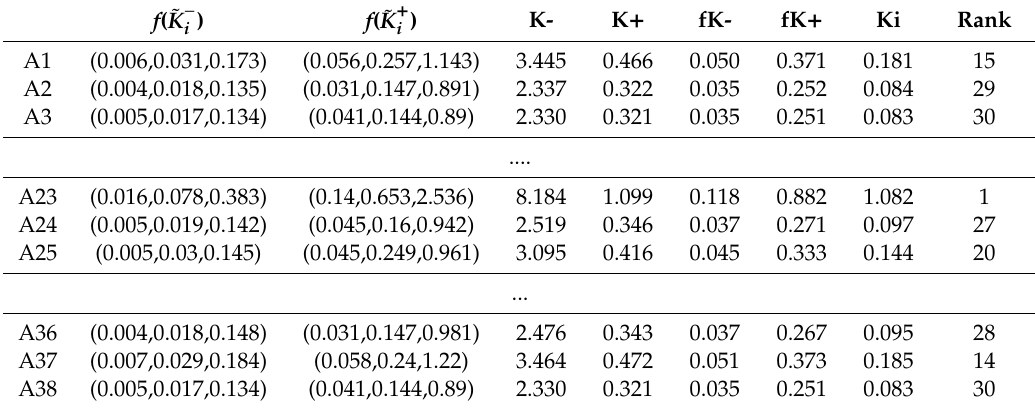
Table 6. Calculation of the two last steps and results of applied fuzzy